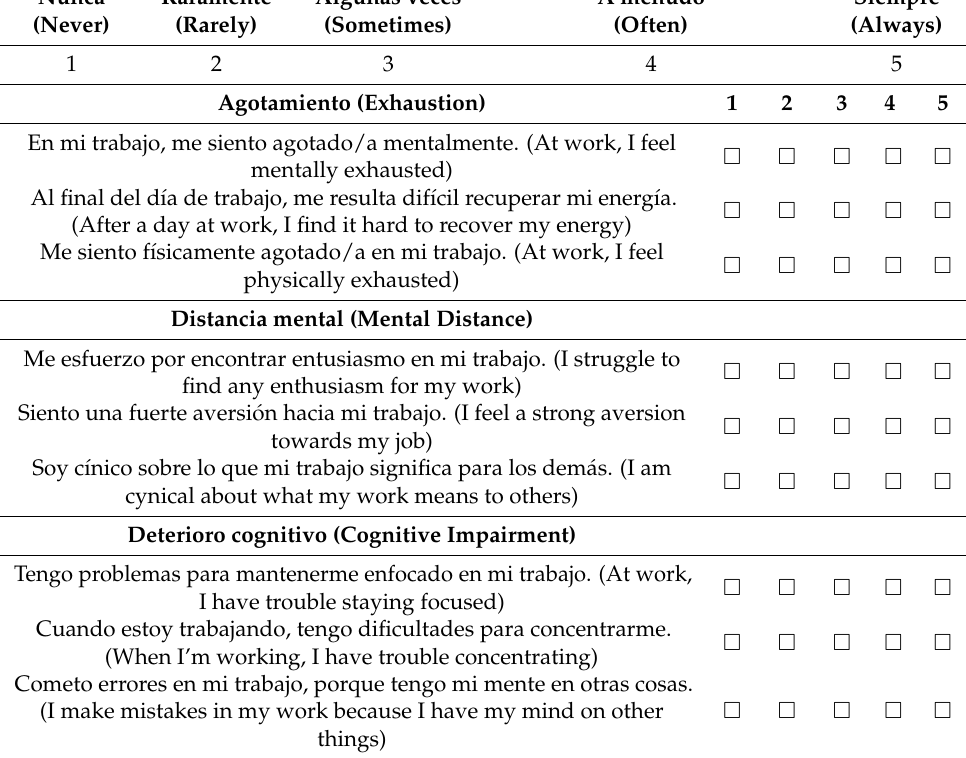
Table A1. Spanish version of BAT-12. Nunca Raramente (Never) Agotamiento